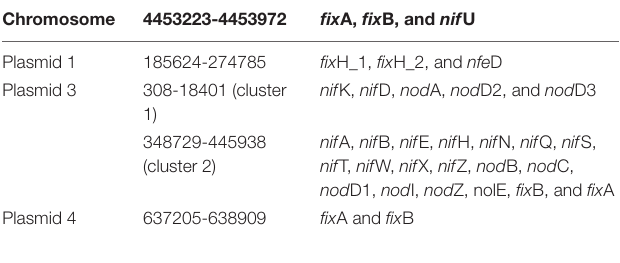
TABLE 2 | Distribution of symbiotic genes in B3 and S2 genomes.